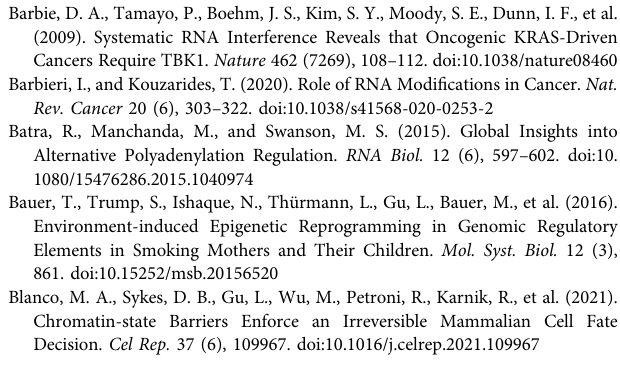
Supplementary Figure S5 | Association between tumor immune microenvironment and 26 A-related RNA modi fi cation “ writers ” . (A) The correlation between the abundance of tumor-in fi ltrating immune cells and RNA regulators (TCGA-SKCM cohort; Spearman analysis; * p < 0.05; ** p < 0.01; *** p < 0.001). (B) Differences of immuneScore between WTAP high expression and low expression groups (Wilcoxon test; p < 0.001). (C) Differences of tumor-in fi ltrating immune cells between WTAP high expression and low expression groups. (* p < 0.05; ** p < 0.01; *** p < 0.001). (D) Differences in the expression of adhesion molecules, MHC molecules, and costimulatory molecules between WTAP high expression and low expression groups. (* p < 0.05; ** p < 0.01; *** p < 0.001). (E) Differences in immune-activated pathways between WTAP high expression and low expression groups. (* p < 0.05; ** p < 0.01; *** p < 0.001). (F,G) Kaplan-Meier curve showing overall survival of SKCM patients between high- and low- WTAP expression groups in the anti-PD-1 immunotherapy cohort (GSE78220 cohort) (F) , and GEO-SKCM cohort (GSE65904) (G) . Supplementary Figure S6 | Unsupervised clustering of 26 A-related RNA modi fi cation “ writers ” in the TCGA-SKCM cohort. (A – D) Consensus matrices of the TCGA-SKCM cohort for k = 2 – 5. (E) The difference in expression of 26 RNA regulators among the writer cluster A, writer cluster B, and writer cluster C. (TCGA- SKCM cohort; * p < 0.05; ** p < 0.01; *** p < 0.001). (F) 2281 differently expressed genes DEGs genes shown in venn diagram. Supplementary Figure S7 | Immune-related molecular characteristics in distinct gene clusters. (A – D) Unsupervised clustering of prognosis-related differently expressed genes (DEGs) in the TCGA-SKCM cohort (k = 2 – 5). (E) Evaluating the abundance of each tumor-in fi ltrating immune cell in three gene clusters using ssGSEA. (* p < 0.05; ** p < 0.01; *** p < 0.001). (F) Difference in immune-related pathways among three gene clusters. (* p < 0.05; ** p < 0.01; *** p < 0.001). (G – I) Difference in the immune-activation (G) , chemokines and cytokines (H) , and immune-checkpoint (I) related gene expression among three gene clusters. (* p < 0.05; ** p < 0.01; *** p < 0.001). Supplementary Figure S8 | The expression of 26 “ writers ” in three gene clusters (GSE65904). (A) The survival curves of three gene clusters (GSE65904; Log-rank test; P < 0.05). (B) The differences in expression of 26 A-related RNA modi fi cation “ writers ” in three gene clusters. (GSE65904; ANOVA analysis; * p < 0.05; ** p < 0.01; *** p < 0.001). Supplementary Figure S9 | The correlation between W_Score and clinicopathological parameters. (A,B) Multivariate Cox regression analysis for W_Score in TCGA-SKCM cohort (A) and GEO-SKCM (GSE65904) cohort (B) shown by the forest plot. (C,D) Difference in W_Score among distinct clinical subgroups [age (C) and T-stage (D) ] in TCGA-SKCM cohort. (* p < 0.05; ** p < 0.01; *** p < 0.001). (E) Evaluating the abundance of each tumor-in fi ltrating immune cell between high- and low- W_Score groups using ssGSEA. (F) Kaplan- Meier curve showing overall survival of SKCM patients between low- and high- W_Score groups (GSE65904) (Log-rank test; P < 0.001). (G) Kaplan-Meier curve showing overall survival of patients between low- and high- W_Score groups in